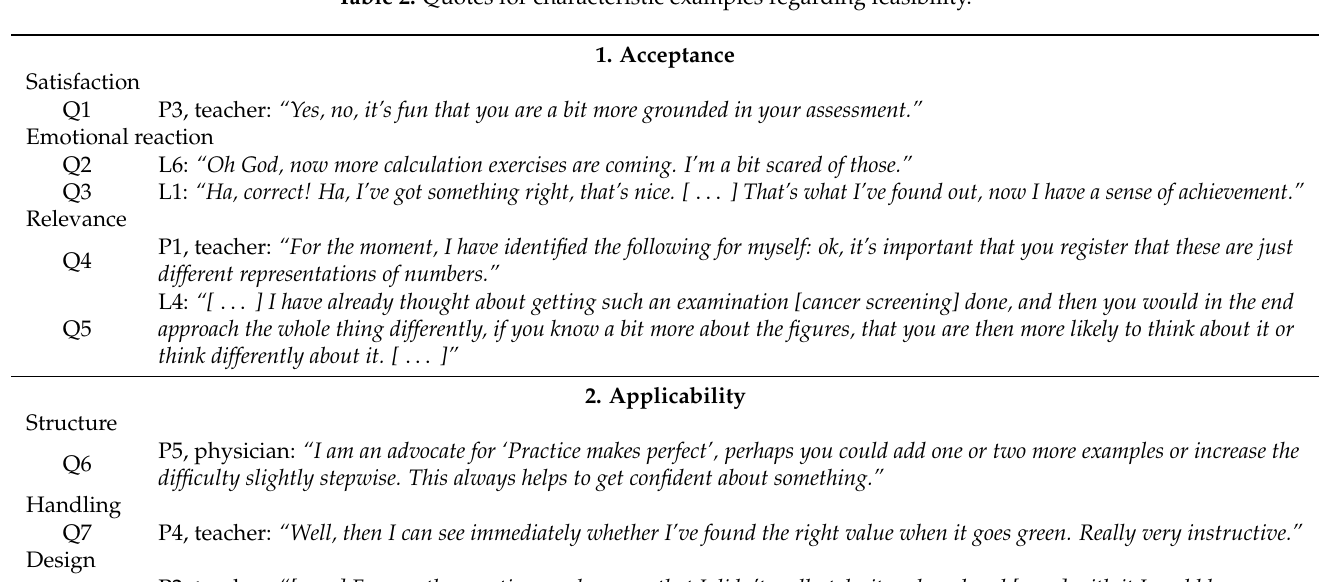
Table 2. Quotes for characteristic examples regarding